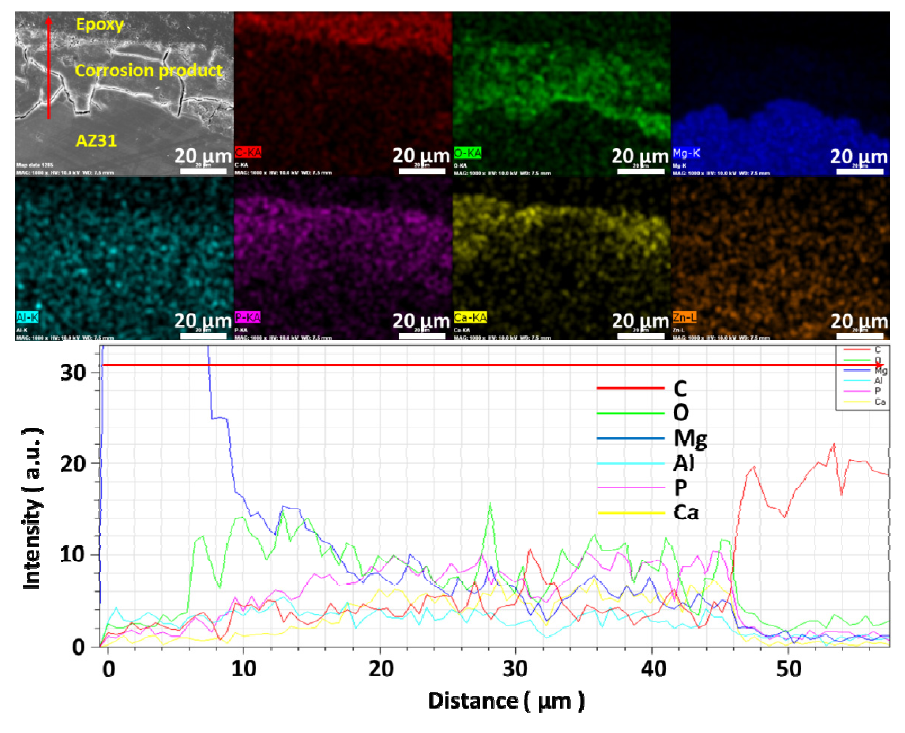
Figure 6. EDX mapping and line analysis of corrosion products formed on the surface after immersion for 10 days in solution #4.